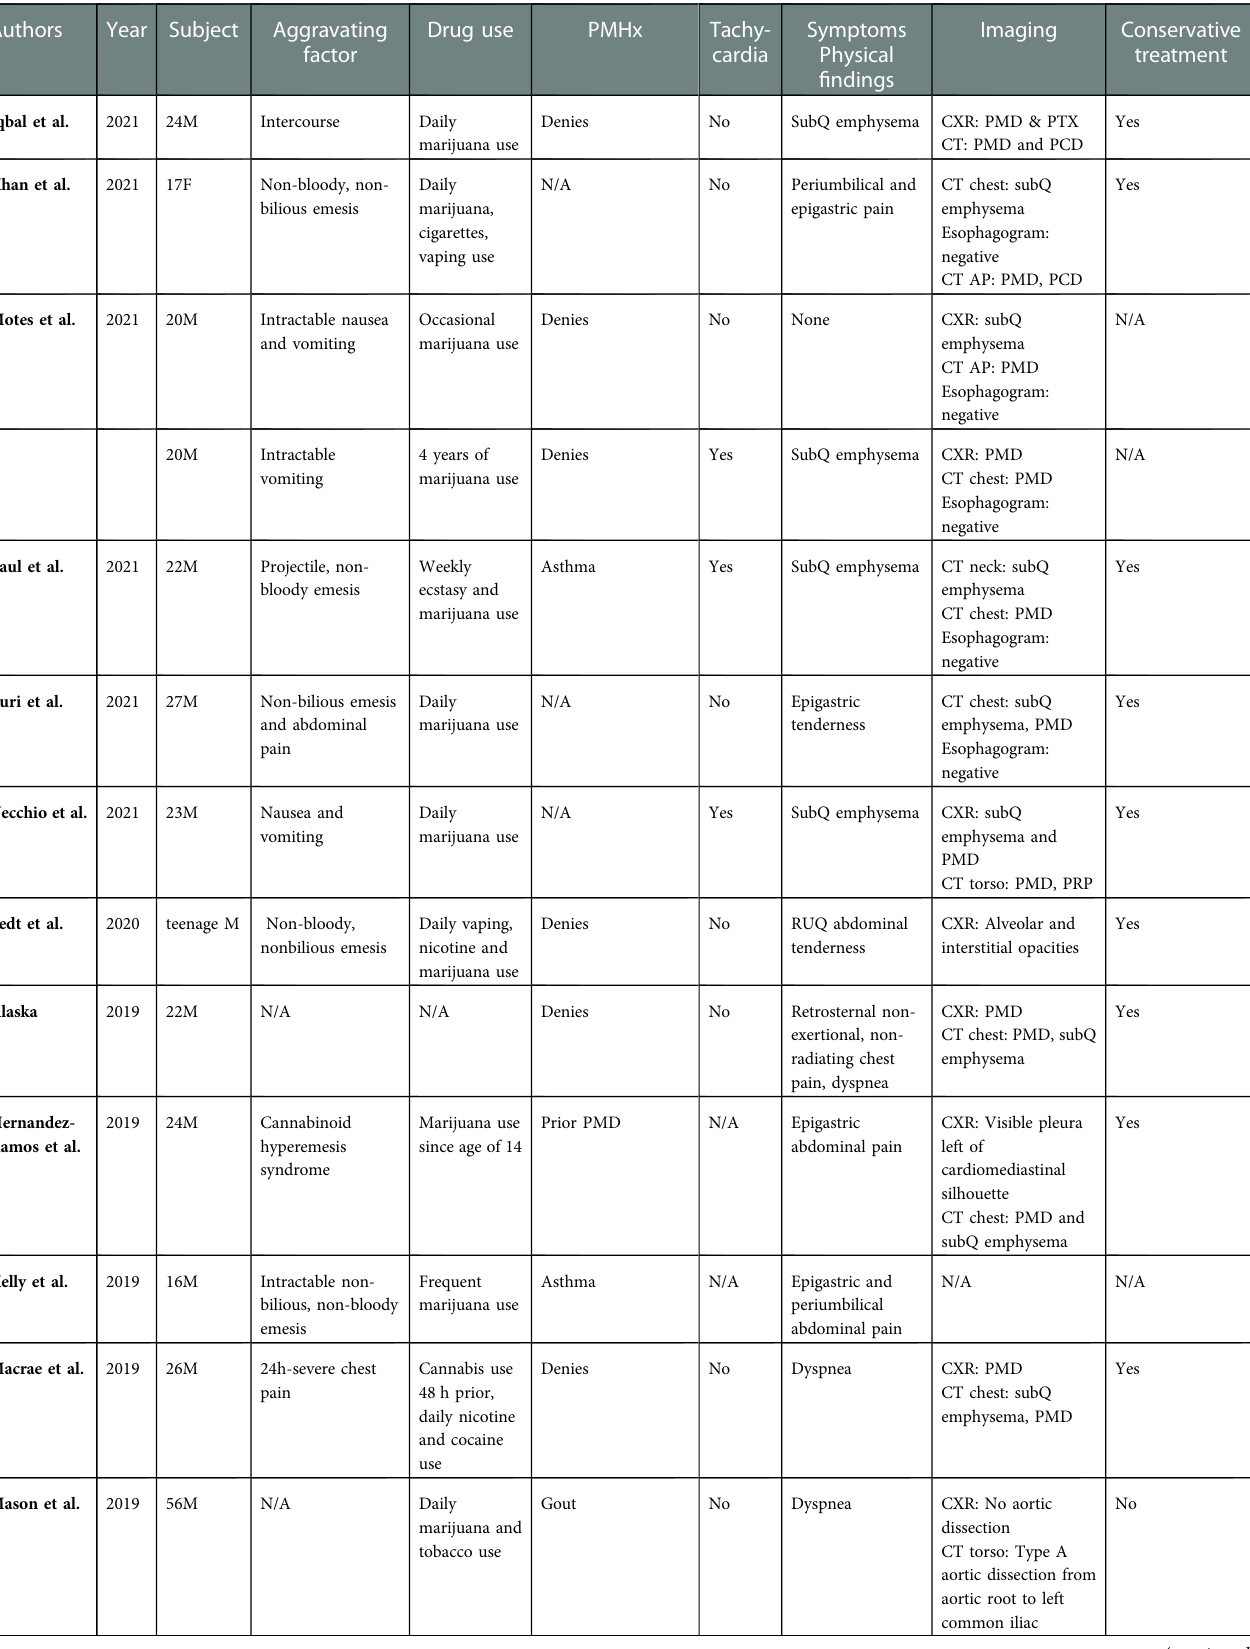
TABLE 1 Literature review of marijuana-associated pneumomediastinum